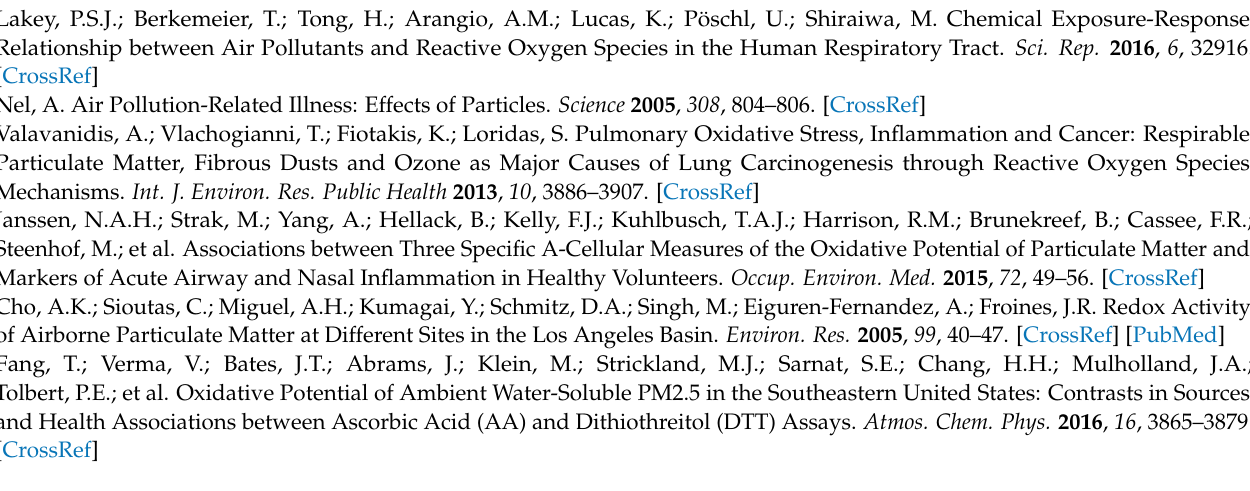
Table S2: Mean ( ± standard deviation) size-resolved concentrations (ng m − 3 ) of water-soluble ele- ments in the cold and warm sampling periods; Table S3: Summery statistics of total* PAH, NPAH, OPAH concentrations for the cold and warm periods (ng m − 3 ); Table S4: Spearman’s rho correlation coefficients of OPmDTT, OPvDTT and MTT cytotoxicity (MTT-reduction mg − 1 PM), with the corre- sponding mass and air volume normalized concentrations of chemical compounds of PM; Figure S1: Average concentrations of (a) PM, (b) PAHs, (c) NPAHs and (d) OPAHs in various size fractions during the cold and warm season (Error bars show min max); Figure S2: Average concentrations of MTT-reduction activity (% of the control), in various size fractions during the cold and warm season (error bars show min and